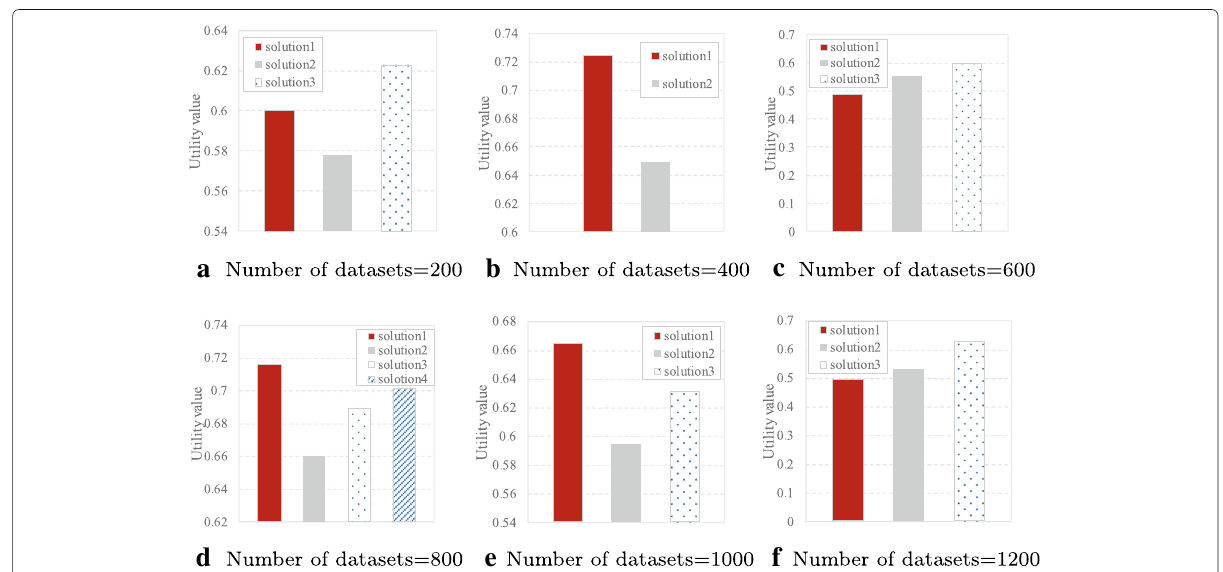
Fig. 5 Comparison of the utility value of the solutions generated by DPMM at different data scales. a Number of datasets = 200. b Number of datasets = 400. c Number of datasets = 600. d Number of datasets = 800. e Number of datasets = 1000. f Number of datasets = 1200